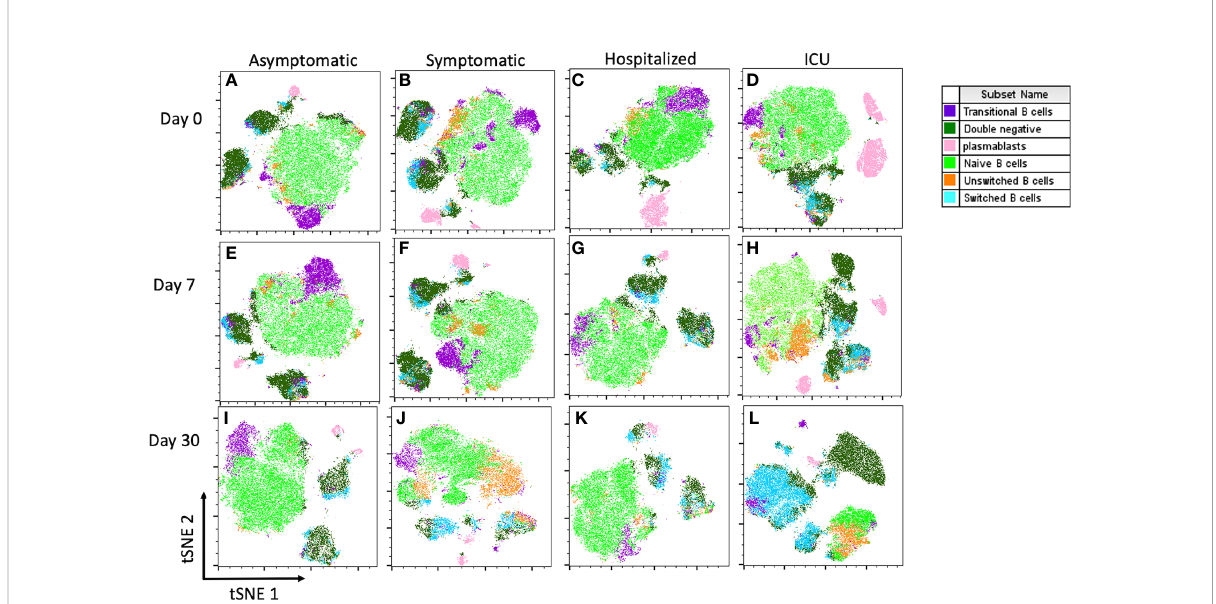
FIGURE 2 t-SNE analysis of B cell subsets in each clinical group at days 0, 7 and 30. Each density plot is derived from random sampling of about 3.000 single events from the concatenated individual cytometry data according to the severity of COVID-19 participants. (A-D) samples at day 0, (E-H) samples at day 7, and (I-L) samples at day 30. *L. was concatenated of only three